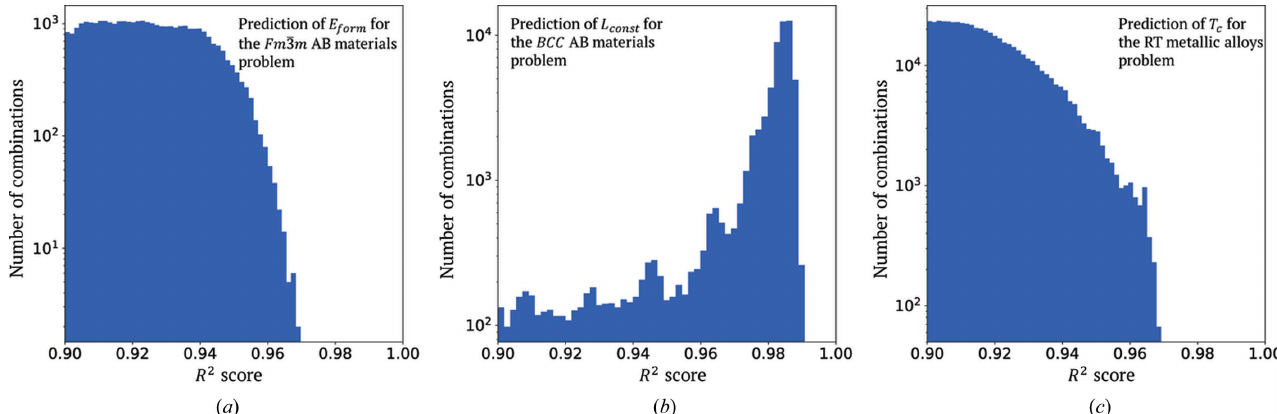
Figure 2 The numbers of predicting variable combinations that yield corresponding prediction models with R 2 larger than 0.90 for different problems: ( a ) the prediction of E form for the Fm 3 m AB materials, ( b ) the prediction of L const for the b.c.c. AB materials and ( c ) the prediction of magnetic phase-transition temperature T C for the rare earth–transition metal